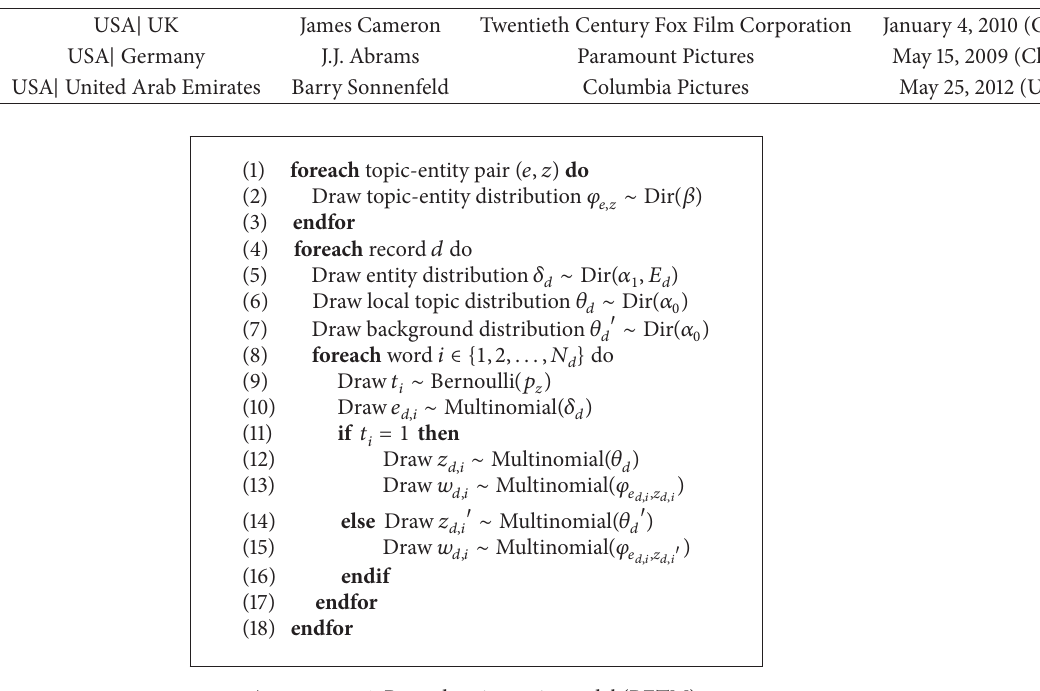
Algorithm 1: Record entity topic model (RETM).